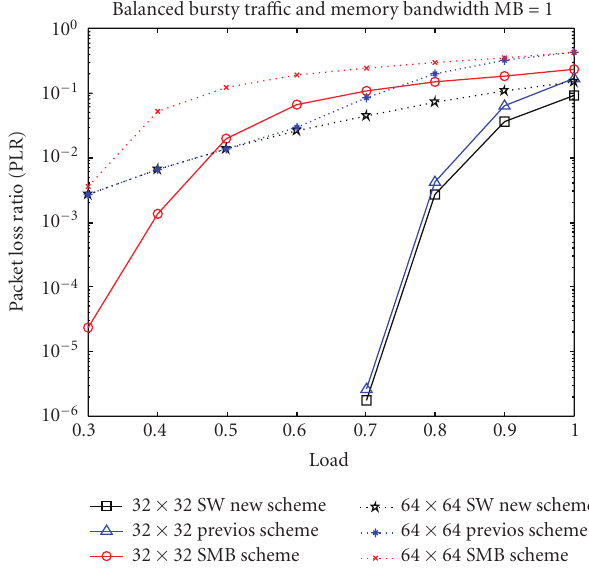
Figure 7: Packet-loss ratio with memory bandwidth (MB = 1) of SW and SMB